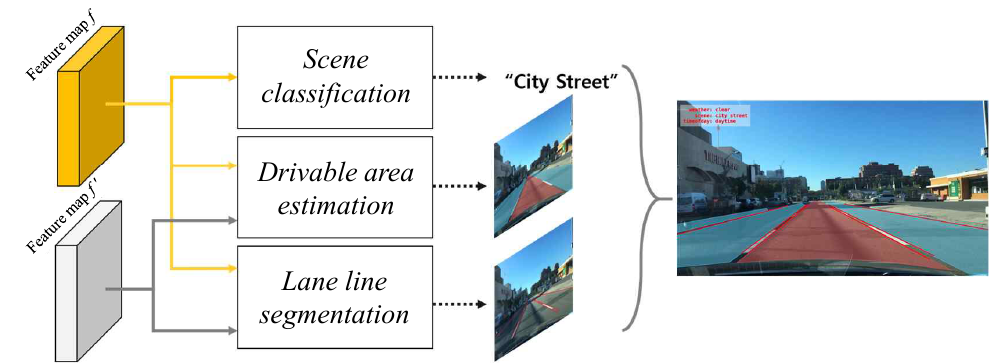
Figure 3. Composition of three decoders for multi-task learning architecture. Each task is trained simultaneously at the decoder using two feature maps having different resolutions. Multi-task learning improves accuracy because losses from different tasks are used to regularize and improve the generalization of another